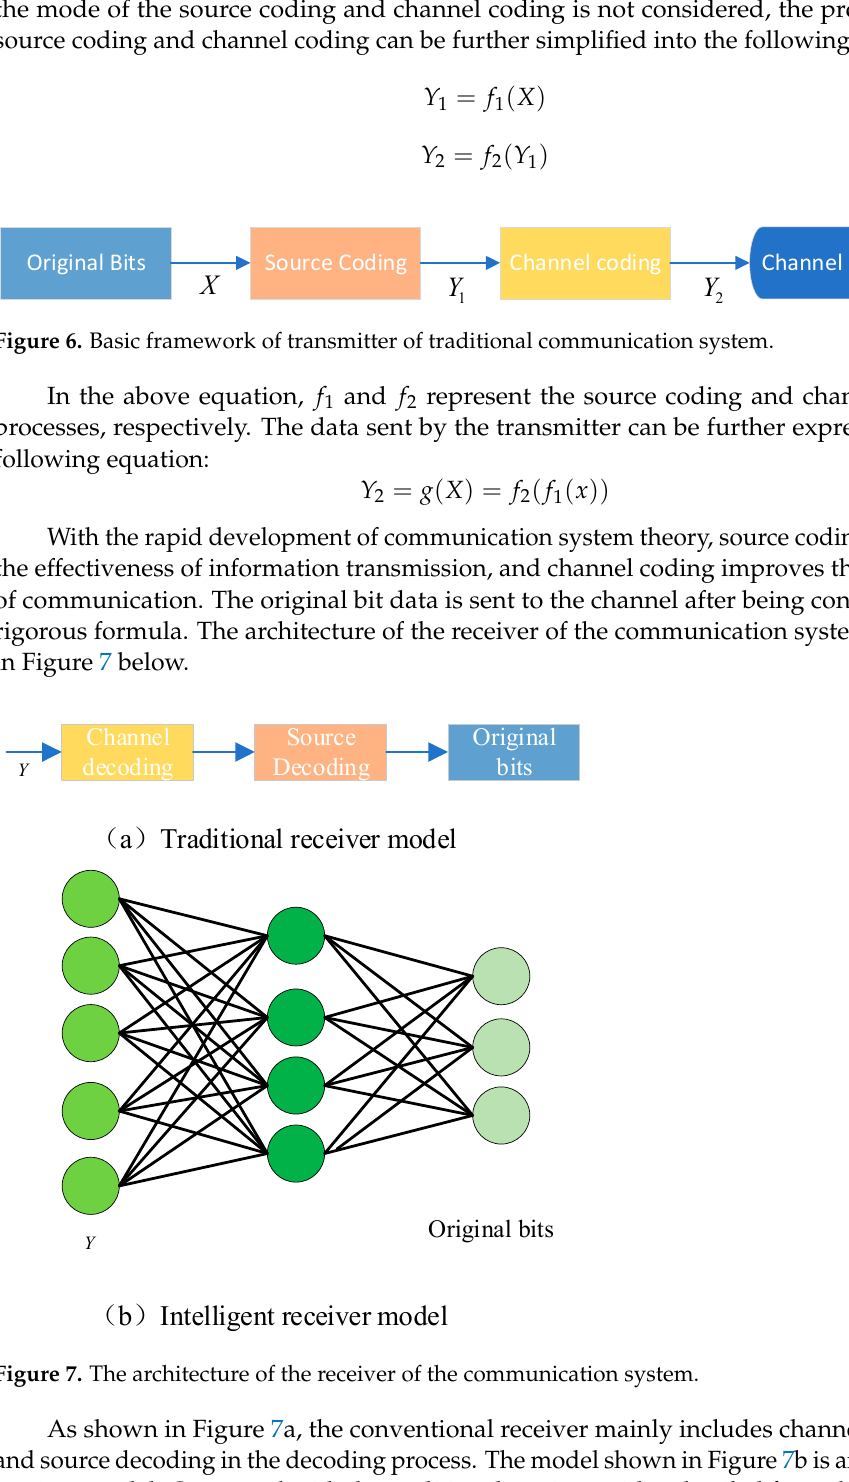
Figure 5. Network structure of intelligent receiver.